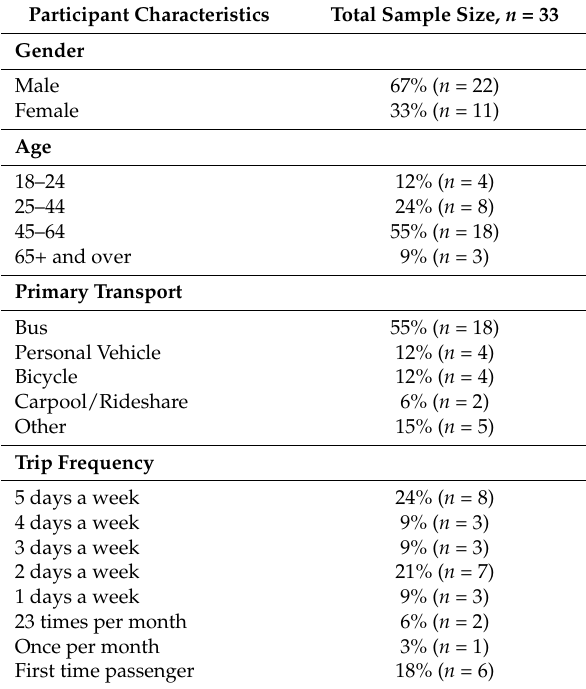
Table 3. Rider characteristics from bus